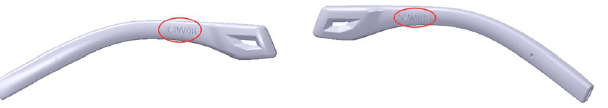
Figure 25. The mark in the plastic glasses legs. From left to right: the right leg, the left leg.